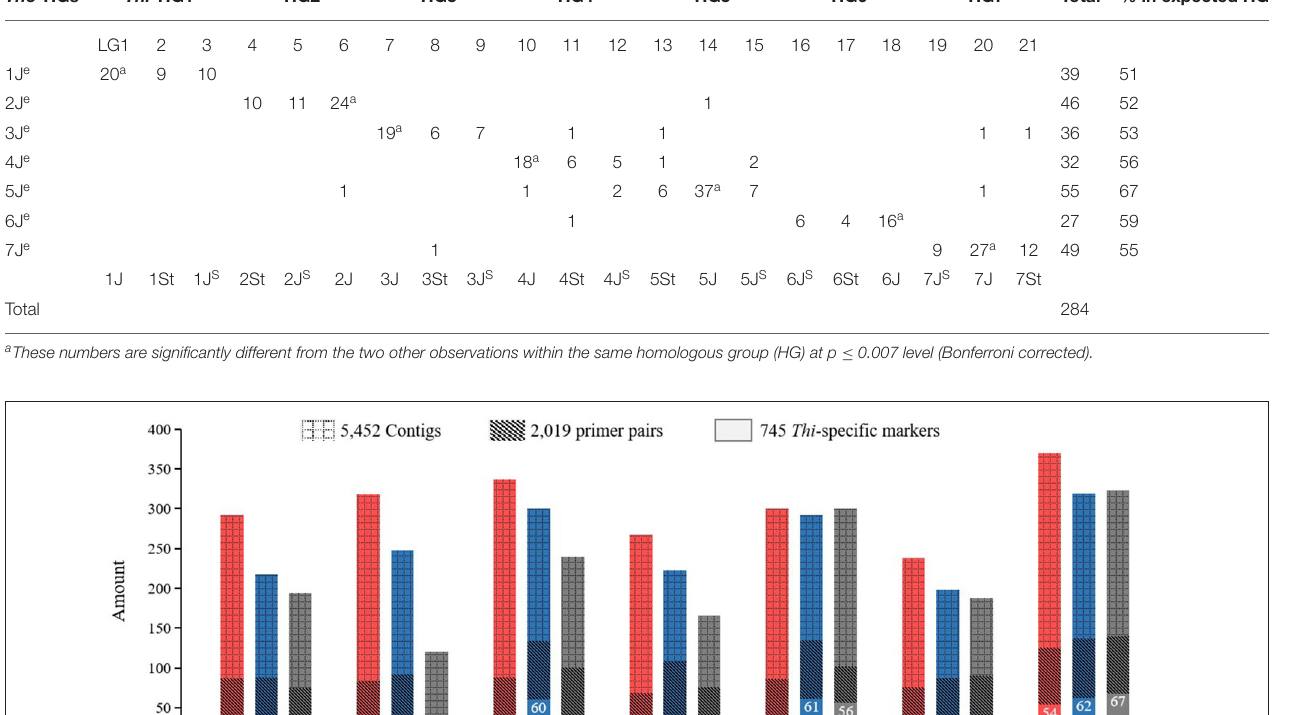
TABLE 2 | Locations of 284 The -CDSs matched with Thi -GBS sequences reported in Kantarski et al. (2017). The